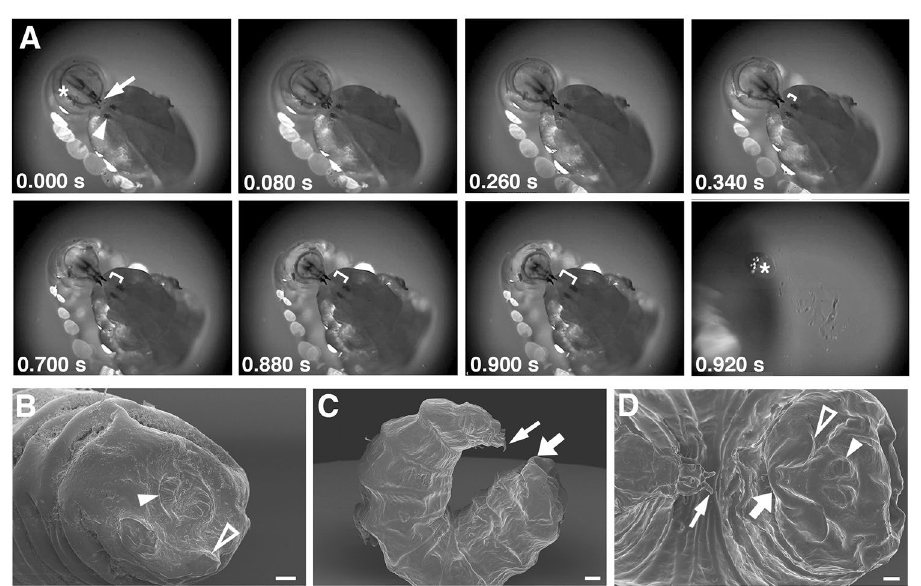
Figure 4. Mouth hooks insert into an epidermal fold during latching. ( A ) Ventral views of a launching C. capitata larvae under a stereo microscope equipped with a high speed video camera. Mouth hooks (arrow) insert in the caudal segment just below the posterior spiracles (arrowhead). During tension generation (0.08– 0.90 s), mouth hooks slide downward, increasing the distance to the spiracles (bracket) and creating a rimmed fold in an epidermal lamella (Suppl. Movie S3). Mouth hook release and take-off last less than 20 ms (0.92 s). Asterisks mark residual liquid used for cleaning the larva. ( B – D ) Scanning electron microscope (SEM) images of C. capitata larvae frozen in liquid nitrogen during crawling ( B ) and shortly before launch ( C , D ). Arrowheads mark the posterior spiracles, open arrowheads mark the caudal ridge. Lateral ( C ) and ventral ( D ) views of the same larva just after freezing-induced mouth hook release. Arrows label the extended mouth hooks, thick arrows mark the epidermal fold (latch). Mouth hooks pull on this fold and their imprints are still visible. Scale bars 100 μm ( B , D ), 200 μm ( C